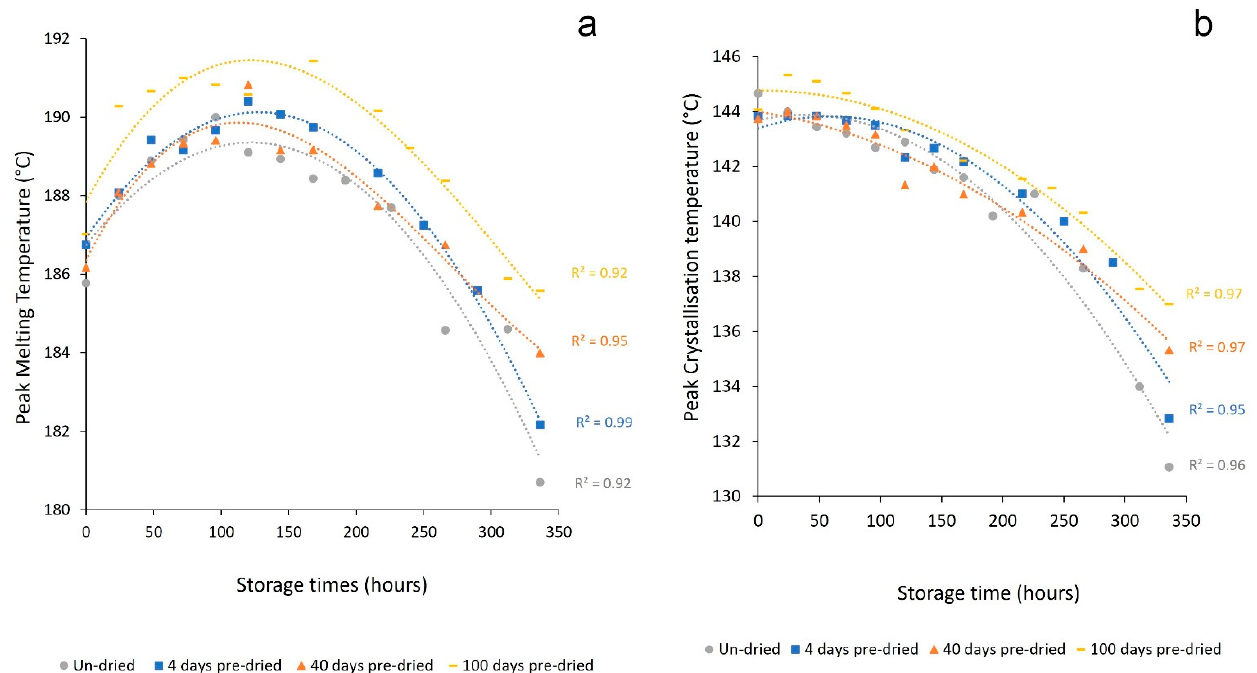
Figure 12. The change in ( a ) peak melting temperature and ( b ) peak crystallisation temperature with storage time, as a function of time spent drying in a desiccator prior to oven conditioning. Error bars were removed for clarity of the data trends, whilst all standard deviation values for these datasets was <1.0 °C, so considered insignificant in relation to the observed trend.